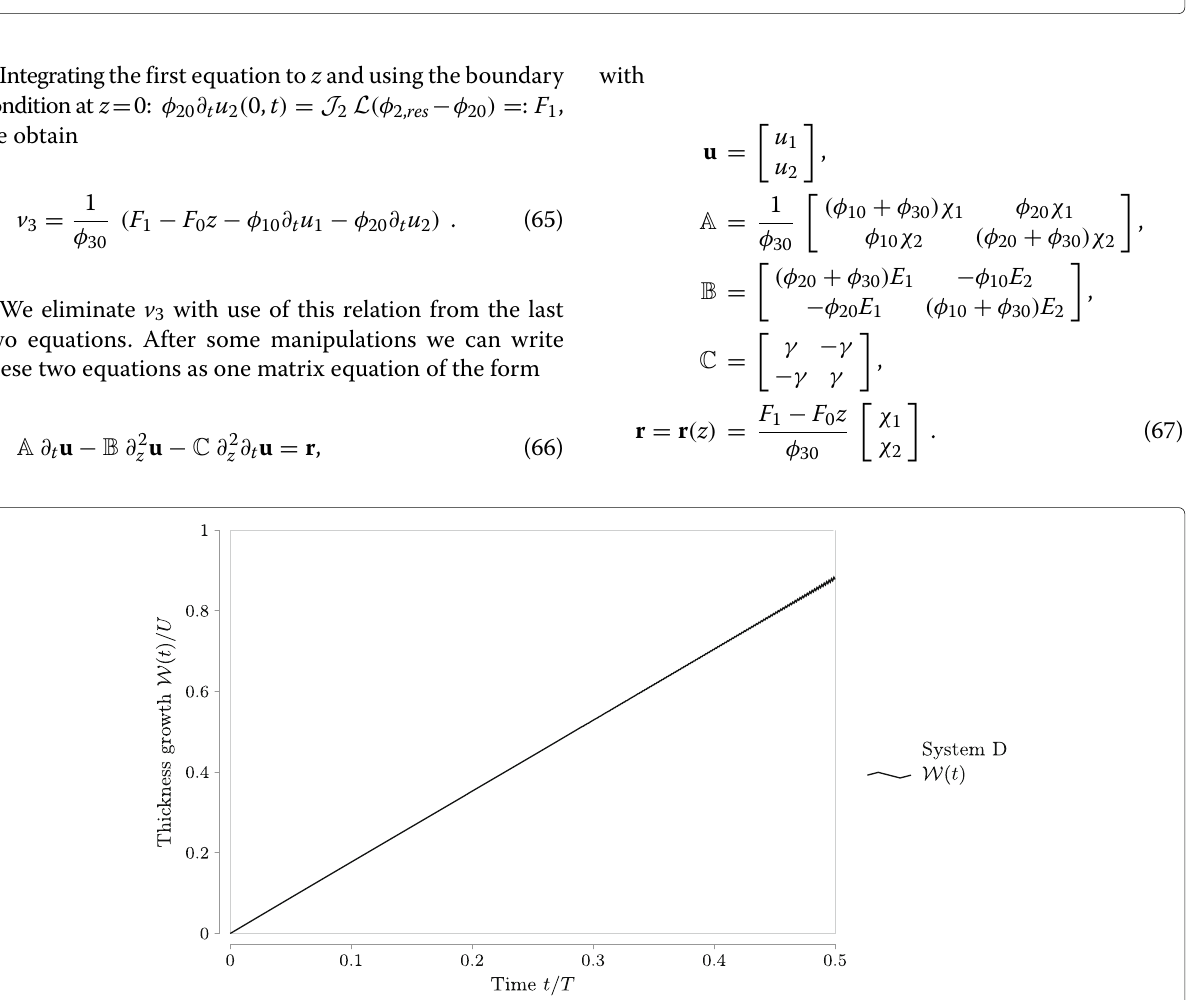
Fig. 7 MATLAB simulation of u 2 ( z , t ) for z ∈ { 0,0.1, ... ,0.9,1 } for A 1 = A 2 = 0 and the other parameters with the values of Table 1. The oscillations in the graphs are due to an unphysical alternating-in-time solution of v 3 ( z , t ) in the MATLAB simulation